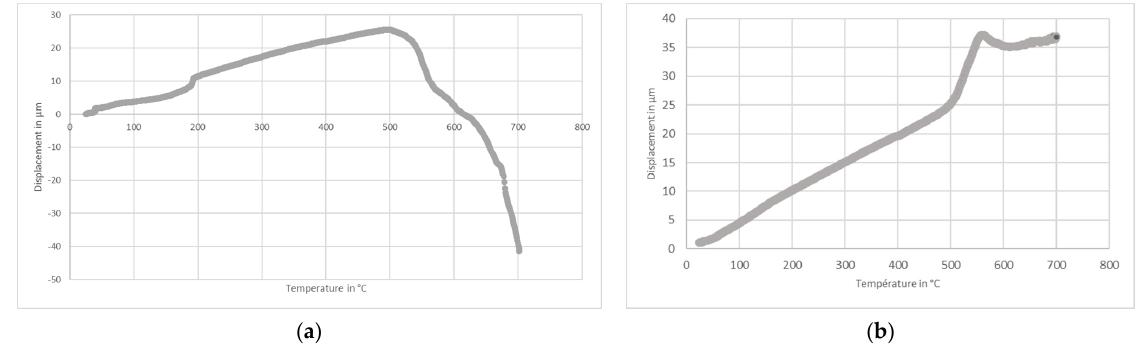
Figure 3. Displacement measurement vs. temperature on SETSYS thermomechanical analyzer ( a ) after one cycling in temperature up to 700 °C and ( b ) after five cyclings in temperature up to 700 °C .